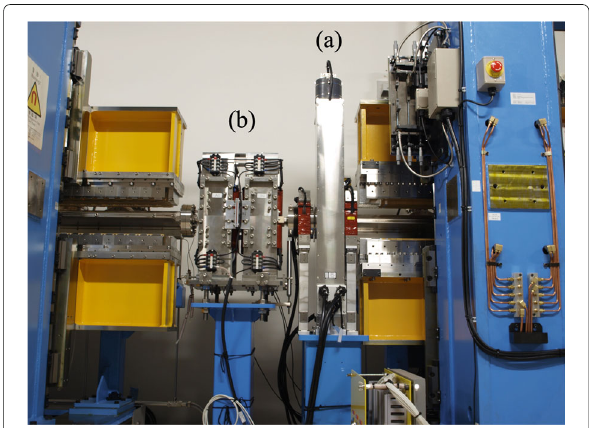
Fig. 7 A photo of the phase shifters of two types: a permanent magnet, PMPS, and b electromagnetic coil, EMPS